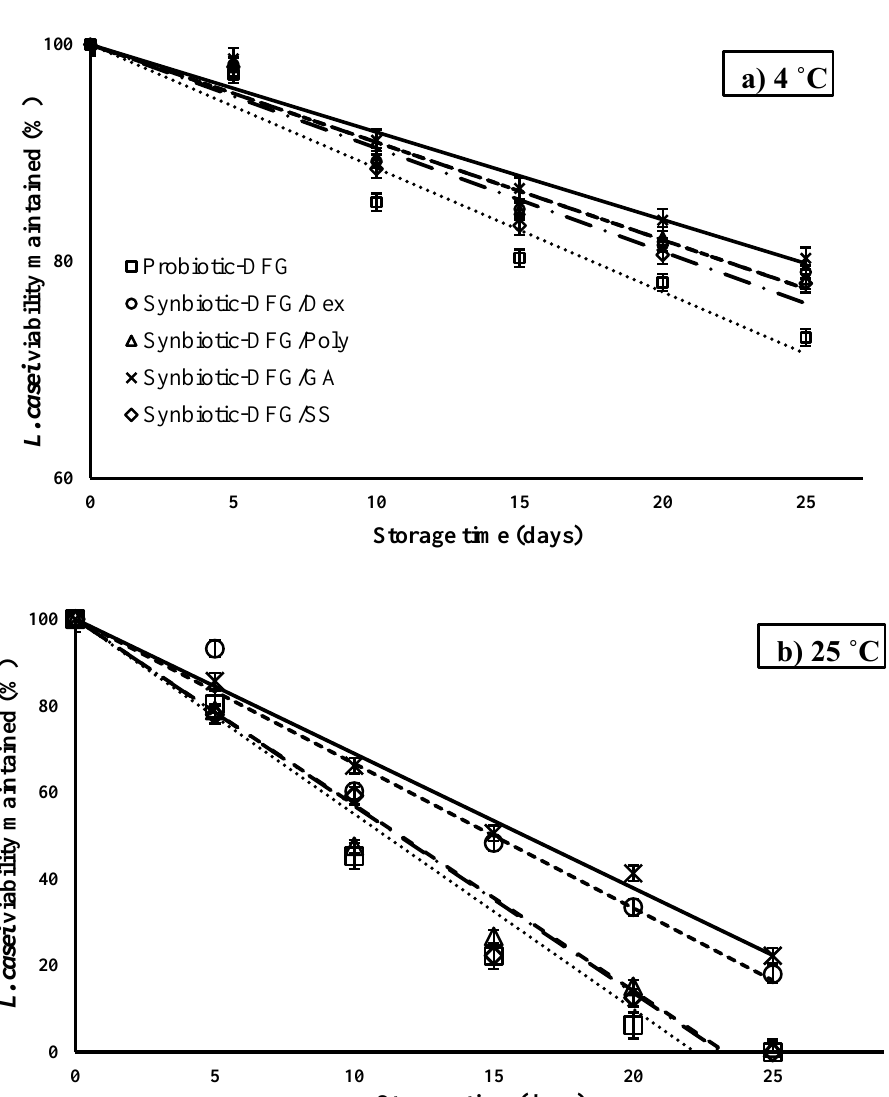
Figure 4. Inactivation curves of L. casei trapped in synbiotic edible films during storage: ( a ) under chilled conditions (4 ◦ C) and ( b ) under room temperature conditions (25 ◦ C) for 25 Table 3. Inactivation rates of L. casei immobilized in plasticized synbiotic DFG and stored either in chilled or room-tem- perature conditions.